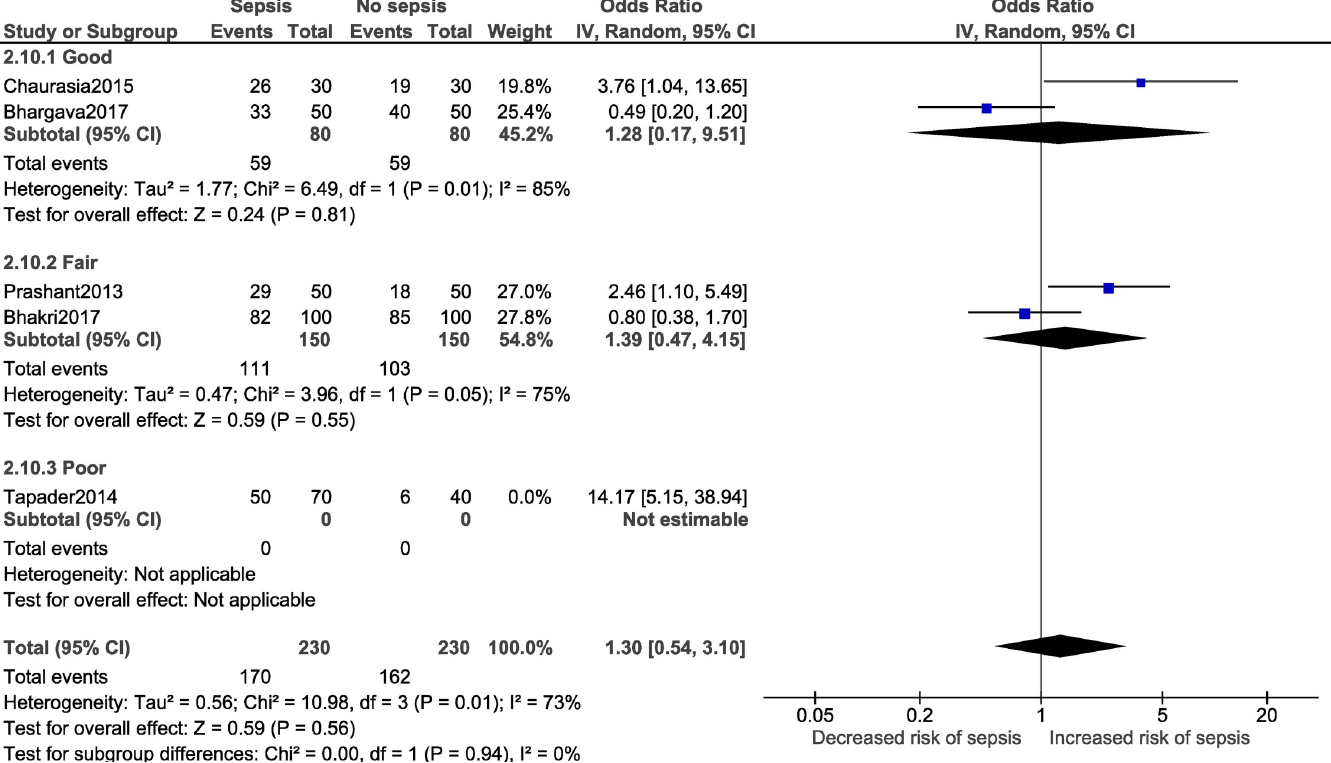
Fig 18. Forest plot showing random-effects meta-analysis of neonates, with and without sepsis, born to mothers who delivered vaginally, sub-grouped by study quality (4 studies) [IV: Inverse Variance; CI: Confidence Interval].